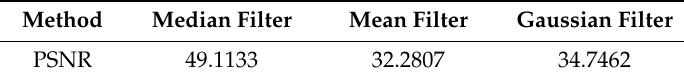
Table 1. PSNR of the three methods (PSNR results).